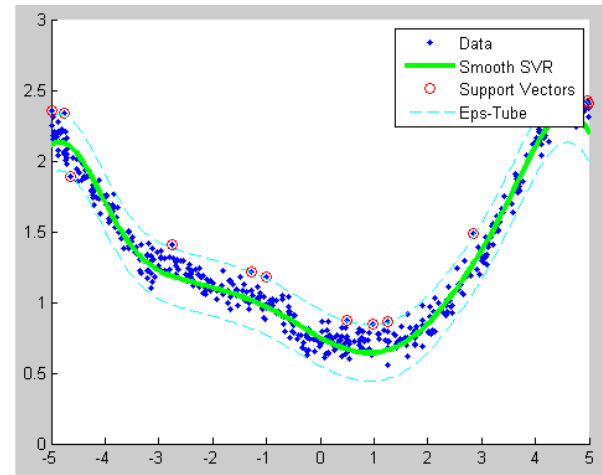
Fig. 1. Illustration of SV regression. Model errors inside the ε -tube are